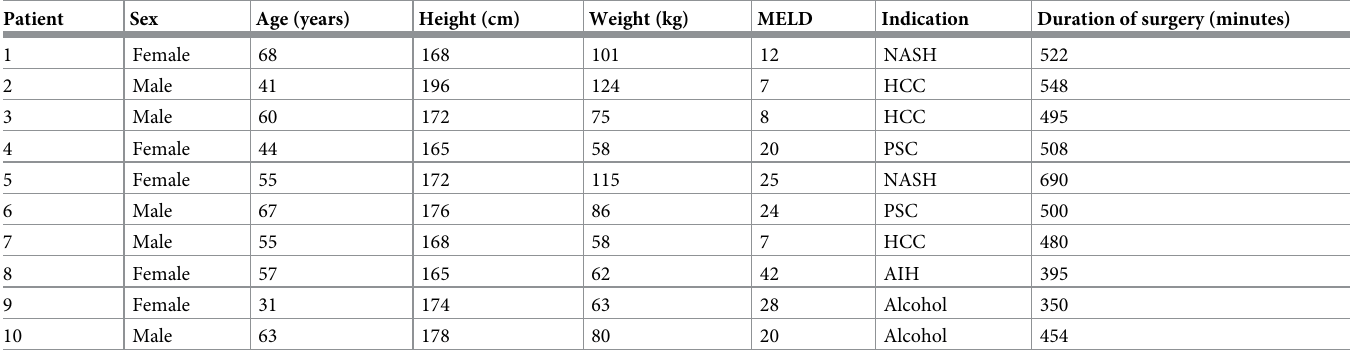
Table 1. Participant